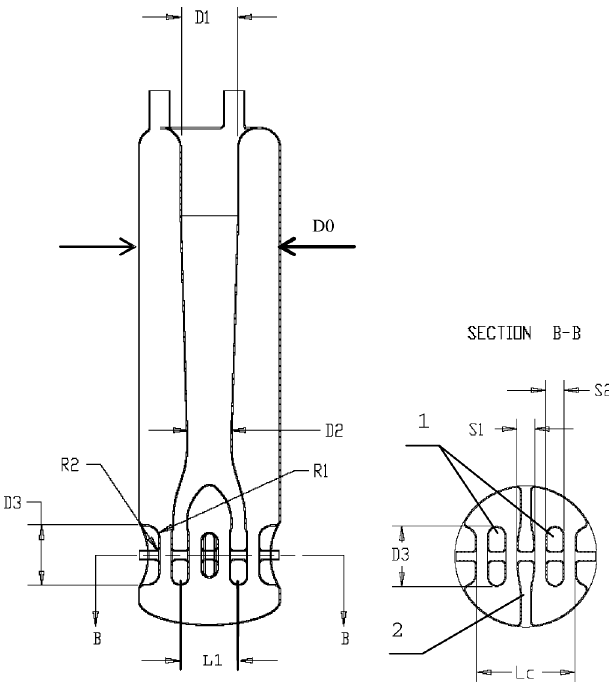
FIG. 2. Main parameters of the cavity to be varied in optimi- zation procedure. 1—intermediate DTs, 2—horizontal cross-